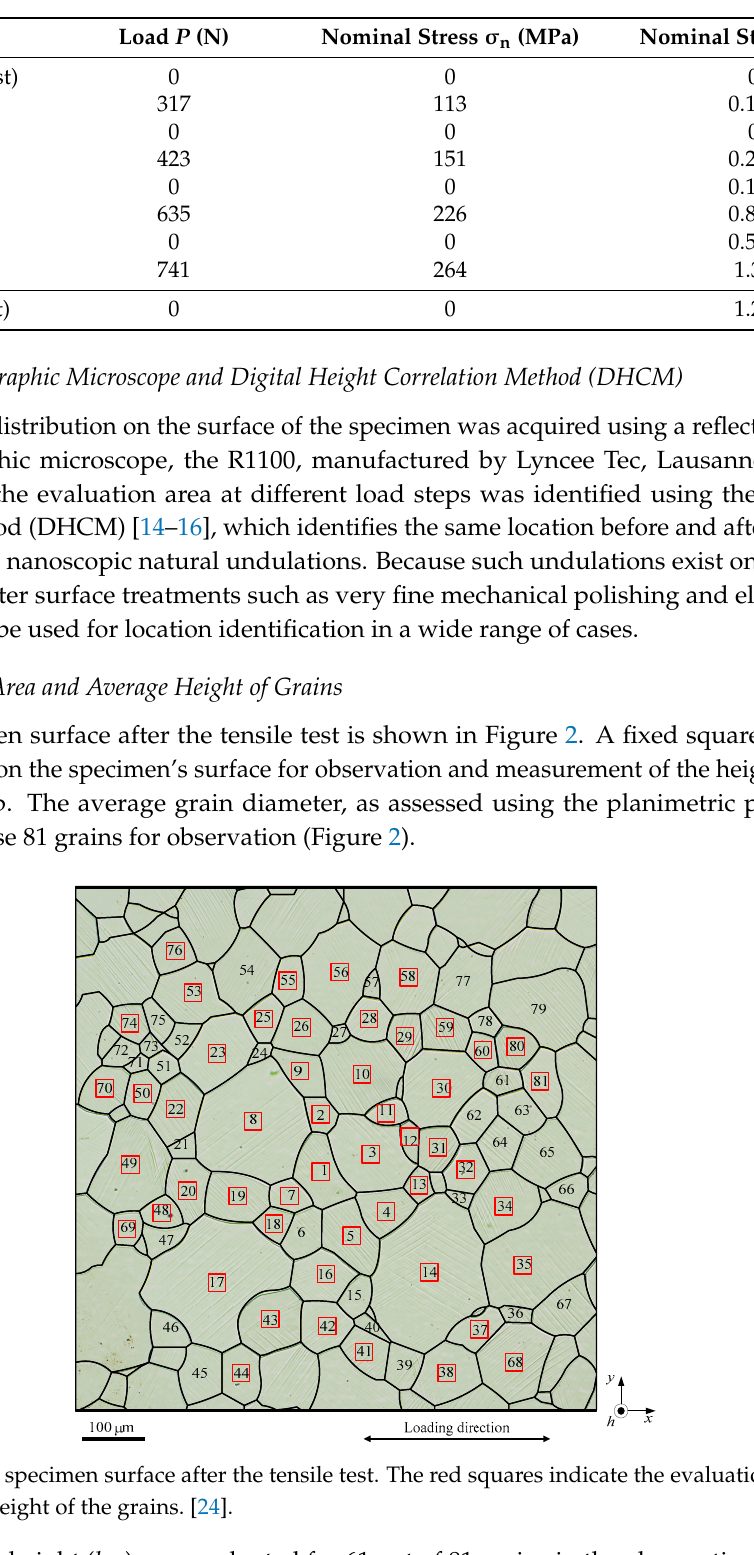
Table 1. Load at each step.